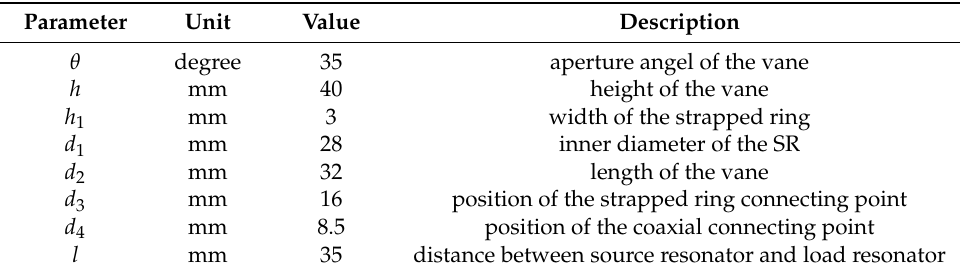
Figure 1. Wireless power transfer (WPT) system based on strapped resonator (SR): ( a ) Coupling model, ( b ) structure of strapped resonator, and ( c ) details of the strapped resonator. Table 1. Dimension parameters of the strapped resonator. SR: strapped resonator.